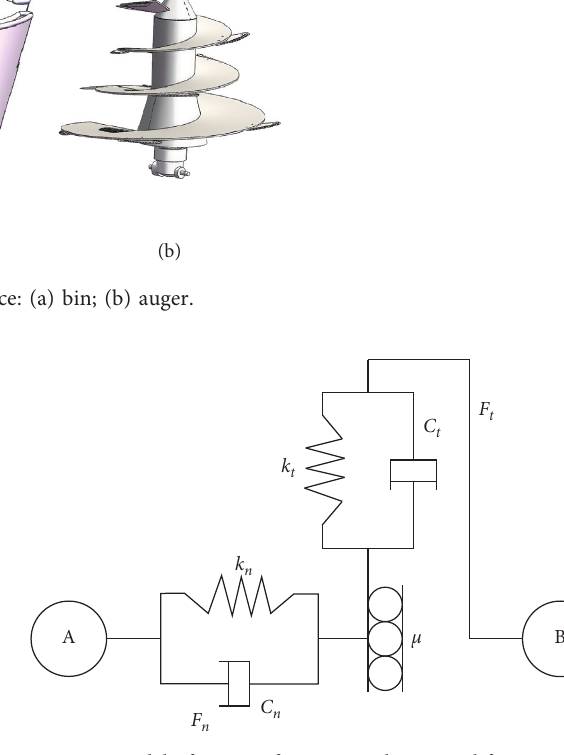
Figure 7: Model of contact force: F n is the normal force, F t is the tangential force, k n and k t are the normal and tangential stiffnesses, C n and C t are the normal and tangential damping coefficients, and μ is the friction